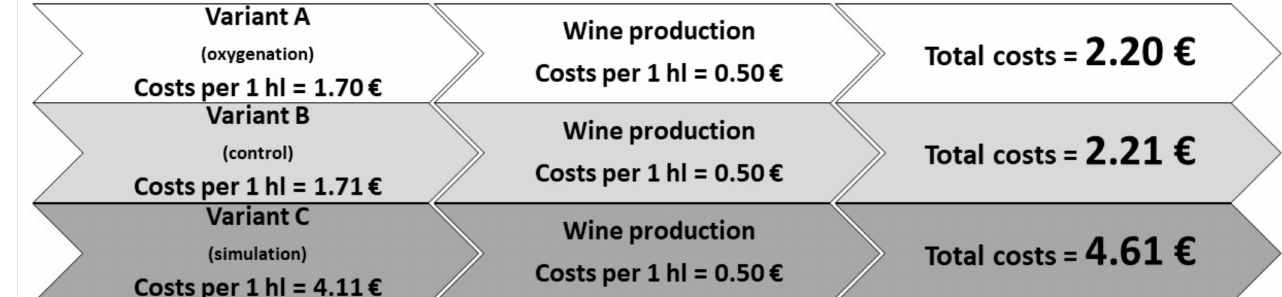
Figure 10. Wine production costs per 100 L for two variants (A and B) and a simulation (in the case of addition of PVPP agent—C variant). Note: Variant A—oxygenation during the removal of must solids with the use of atmospheric oxygen for the elimination of hydroxycinnamic acids content; Variant B—reductive removal of must solids with use of sulphur dioxide without elimination of hydroxycinnamic acids; Variant C—simulation based on removal of must solids with use of sulphur dioxide with the elimination of hydroxycinnamic acids with use of polyvinylpolypyrrolidone